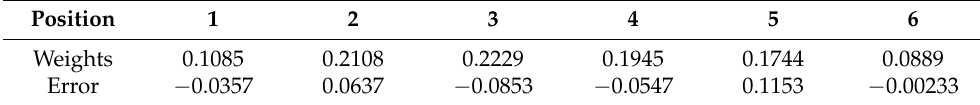
Figure 13. Temperature distribution at the hot end of the thermopile (M = 6). Table 4. Electric power proportion ξ m and its calculated responsivity error.